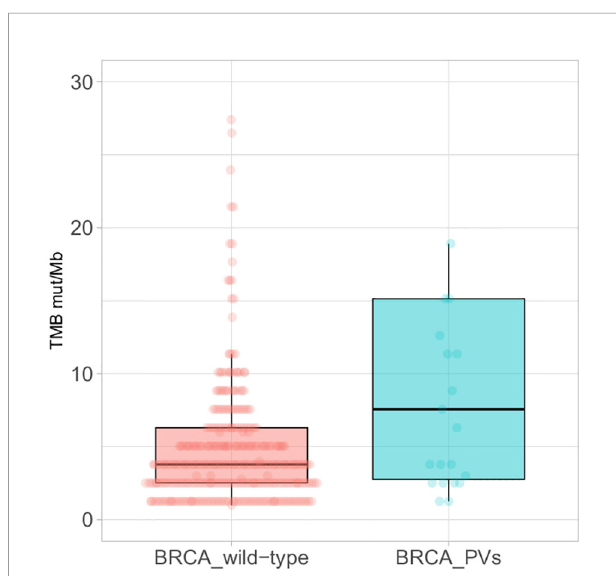
FIGURE 3 | Boxplots of the Tumour Mutational Burden (TMB) in BRCA wild- type tumours (left) and tumours with BRCA pathogenic/likely pathogenic variants (PVs) (right); extreme outliers (TMB >30 mut/Mb) are not